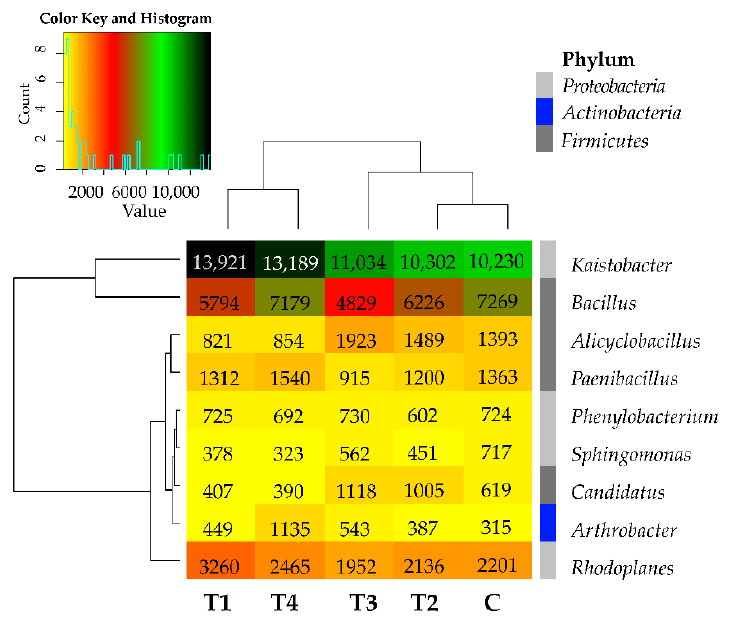
Figure 4. Relative abundance of the predominating bacterial genera in the soils tested with the dif- ference between ratios at ≥ 1%. Tebuconazole doses in mg kg − 1 : C—control soil, T1—0.01 mg, T2— 0.1 mg, T3—0.5 mg, T4—1.0 mg.